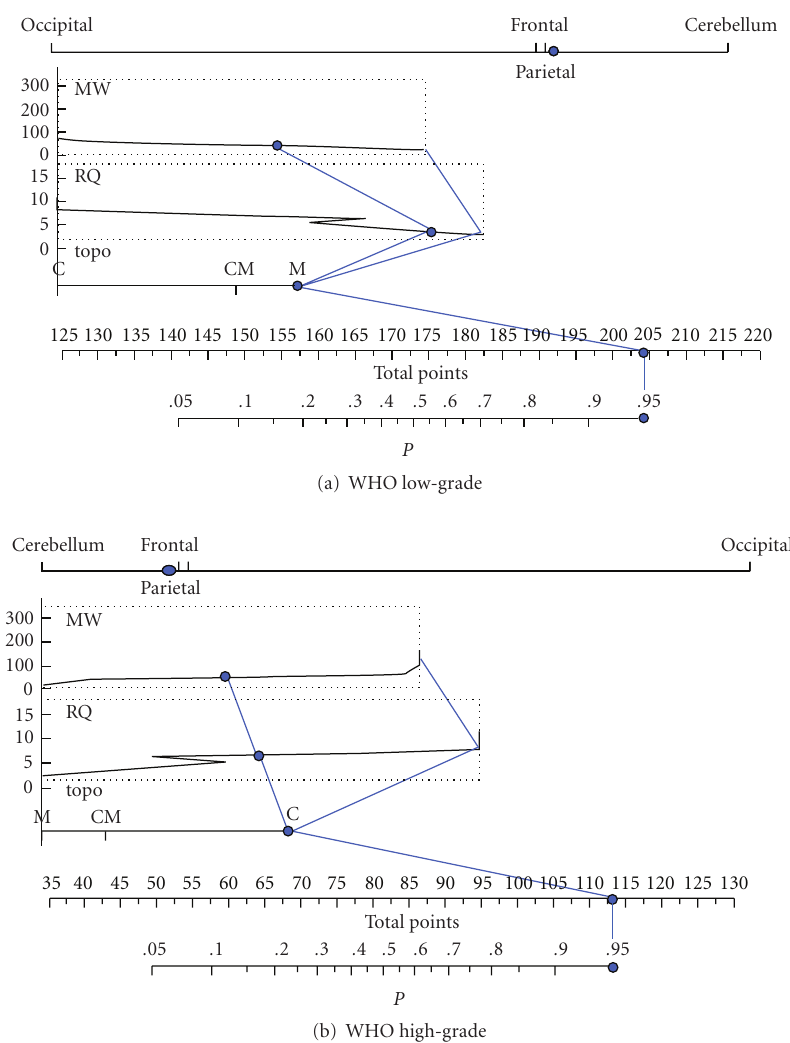
Figure 6: Nomogram association analysis between Dpl features and astrocytomas. Astrocytoma specimens, grouped in low-(WHO I and II) and high-grade (WHO III and IV), were then associated with Dpl molecular mass (MW), relative quantity (RQ), and topology (topo, C:cytosol, M:microsomal, and CM:both) data. Continuous line-delineated sectors corresponded to target probabilities for low-or high grading sorting of P = . 95. Total points indicated the sum of the points for each